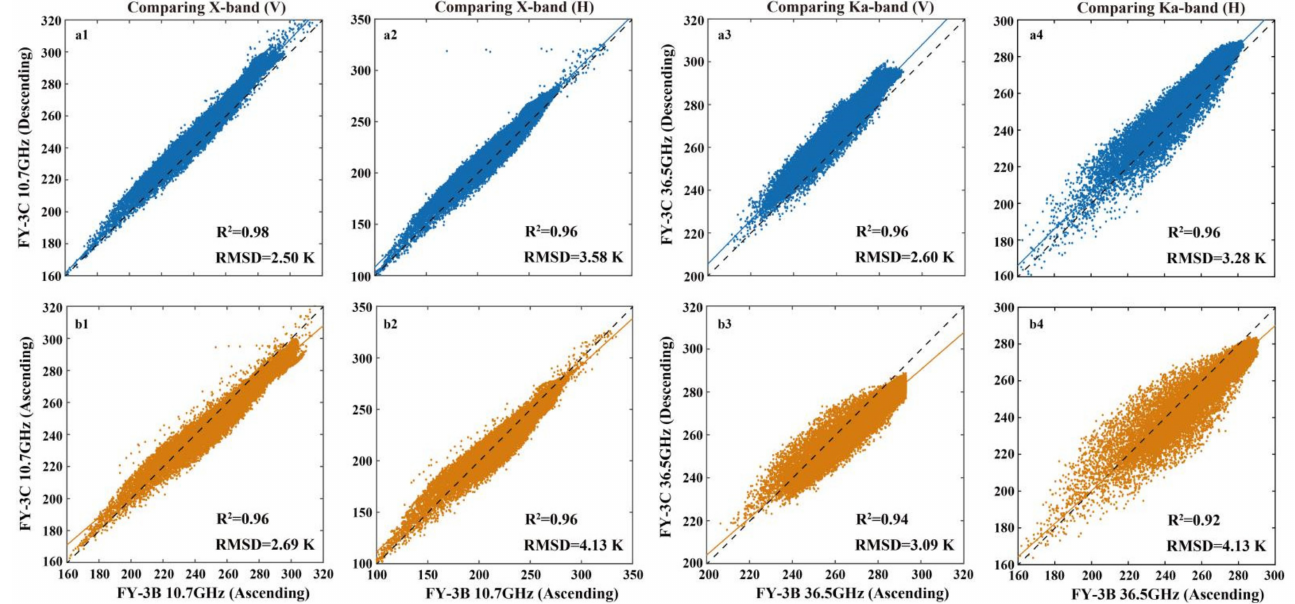
Figure 2. Intercomparison of the TB of FY-3B and FY-3C MWRI observations. ( a1 , b1 ) X-band vertical polarization; ( a2 , b2 ) X-band horizontal polarization; ( a3,b3 ) Ka-band vertical polarization; ( a4,b4 ) Ka-band horizontal polarization (Unit:K). The abscissas represent FY-3B TB, and the ordinates represent FY-3C TB. The orange scatter points indicate ascending data, and blue scatter points indicate descending